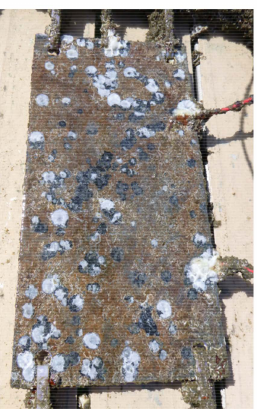
Figure 10. Condition of the initially clean panel after scraped